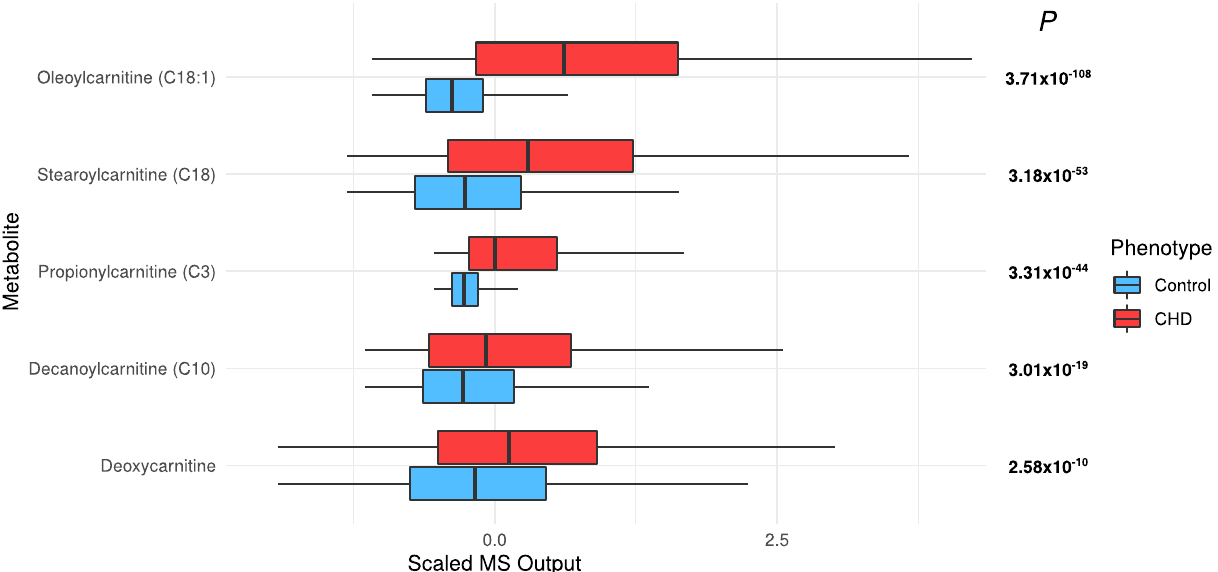
Figure 3. The distribution of significant acylcarnitines in the CHD patients and the controls. High concentrations of sphingolipids : Sphingolipids were significantly increased in the CHD patients: sphingosine 1-phosphate (S1P) (FDR p = 4.79 × 10 − 142 ) and sphingosine (FDR p = 8.33 × 10 − 102 ) (Figure